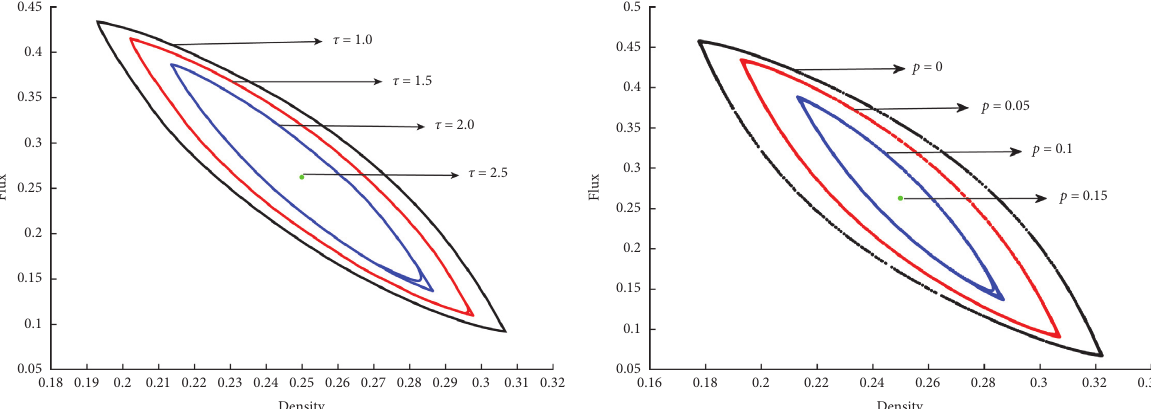
Figure 8: Hysteresis loops of traffic flux and density for (a) τ � 1 , 1 . 5 , 2 , and 2 . 5 with fixed c � 0 . 05 and (b) p � 0 , 0 . 05 , 0 . 1 , and 0 . 15 with fixed c � 0 .